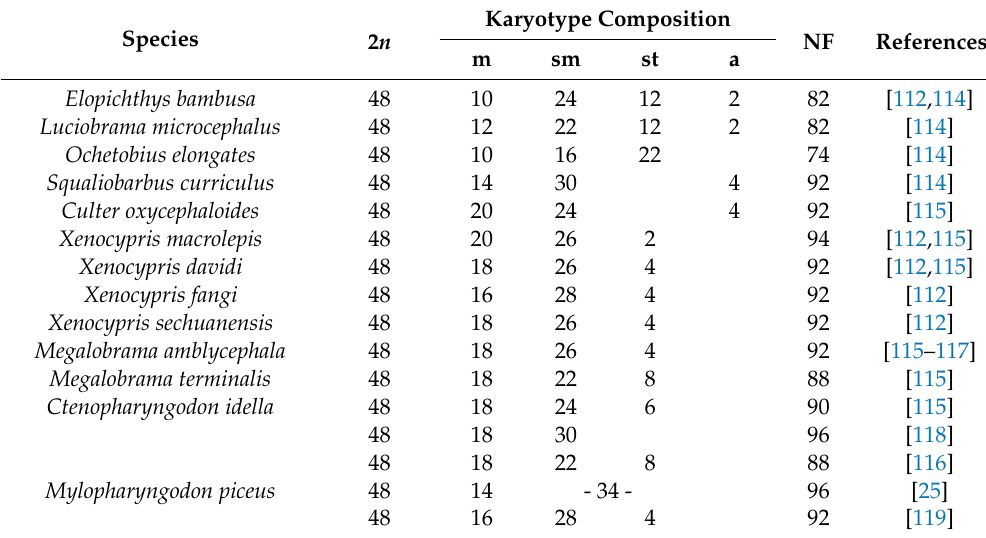
Table 2. Review of reported cytogenetic data for members of the monophyletic clade of several East Asian morphologically distinct